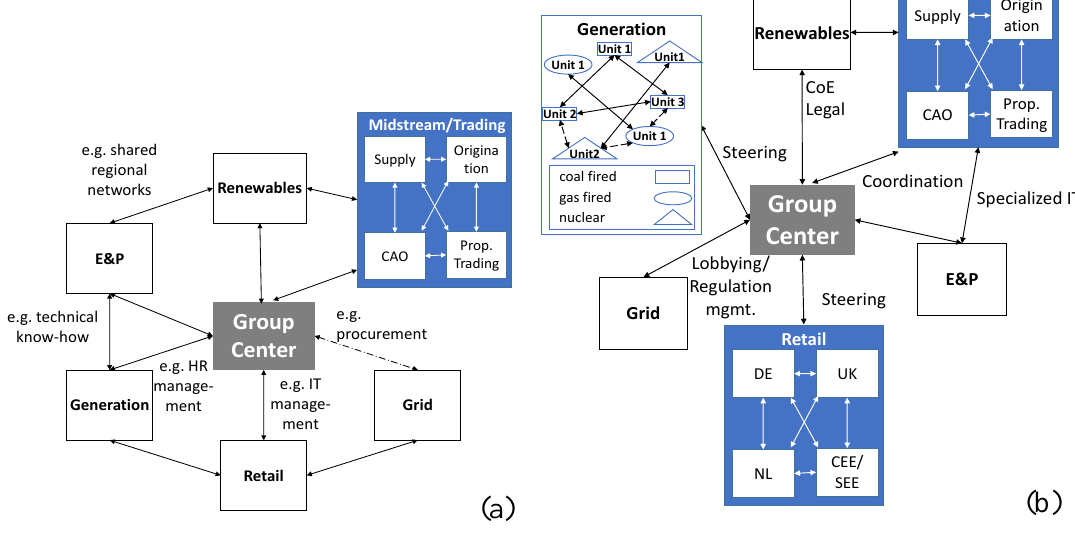
Figure 15. Illustration of the synergy clusters “shared services” ( a ) and “best practice” ( b ). Own illustration, based on RWE internal information.